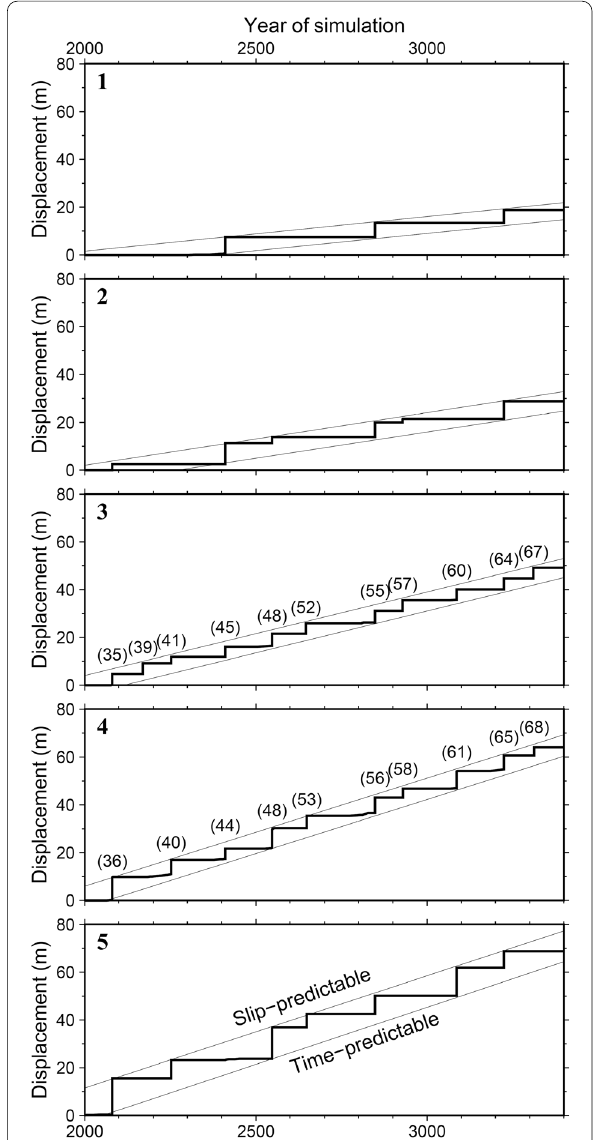
Fig. 7 Time evolution of cumulative slip displacement (thick line) at locations marked by points 1–5 in Fig. 4f. Numbers in parentheses are event numbers, as shown in Figs. 6 and Additional file 1: S2. Upper and lower thin lines indicate slip-predictable and time-predictable models,